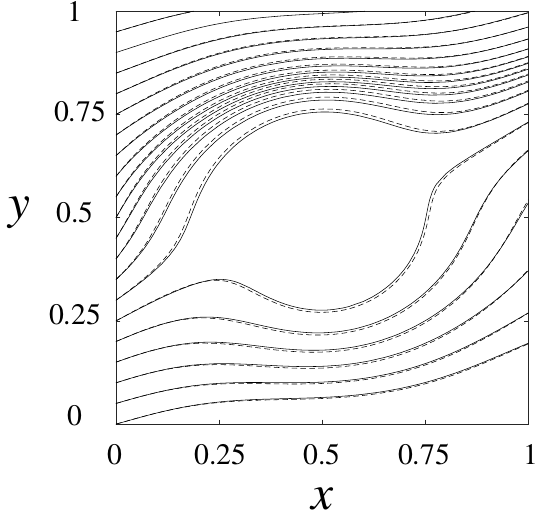
Figure 9. Horizontal ( xy ) projection of an array of streamlines starting at positions uniformly distributed along the segment x = 0; z = z ,0 ≤ y ≤ 1 for the cell geometry specified by α = 1.5, d o = 0.4. Continuous lines: z = 3/4 (symmetry plane). Dashed lines: z = 1.3, corresponding to the maximum intensity of the v z